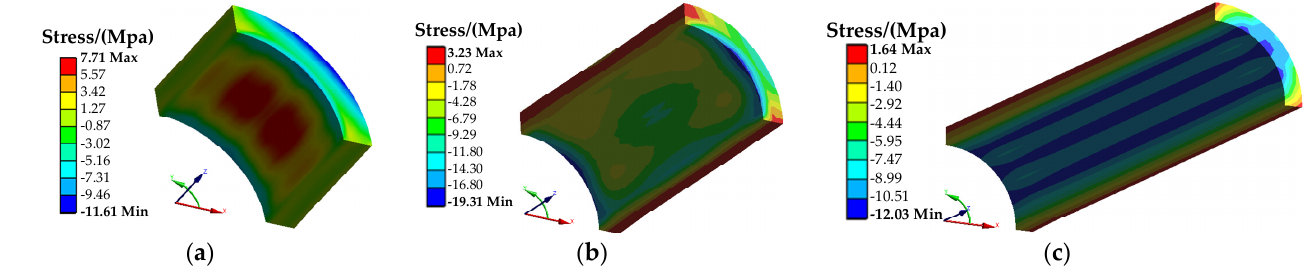
Figure 19. Permanent magnets tangential stress distribution under the three cases at rated speed at a cold state: ( a ) Case 1; ( b ) Case 2; ( c ) Case 3.